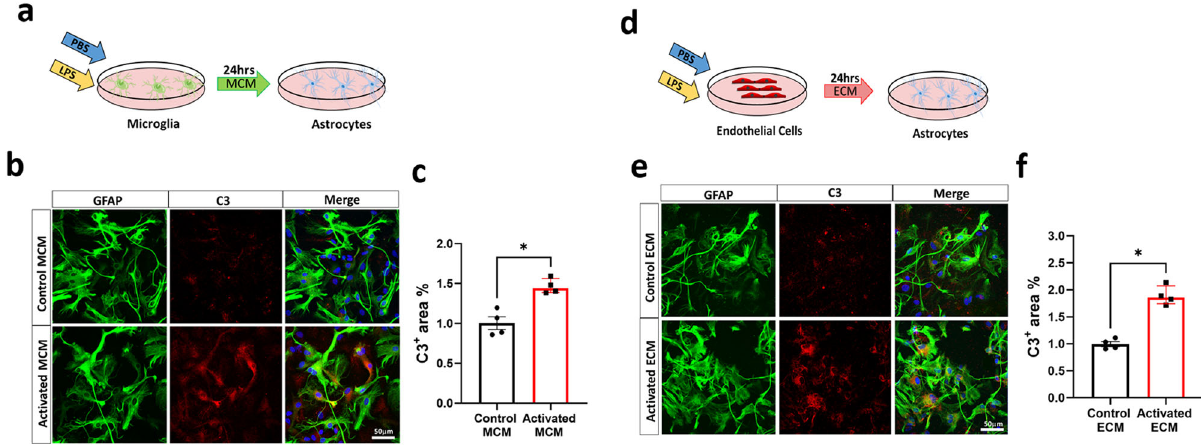
Fig. 1 C3 + Astrocytes are induced by LPS-Activated ECM. a Schematic diagram showing treatment of astrocytes with control or activated microglia conditioned medium (MCM) b Double immuno fl uorescence of complement component 3 (C3, red) and astrocytes (GFAP, green) treated with control or activated MCM in primary astrocyte cultures. C3 and GFAP immunoreactivity overlay (merge) c Quanti fi cation of C3 + area (%) of control or activated MCM treated astrocytes. d Schematic diagram showing treatment of astrocytes with control or activated endothelial conditioned medium (ECM) e Double immuno fl uorescence of complement component 3 (C3, red) and astrocytes (GFAP, green) treated with control or activated ECM in primary astrocyte cultures. C3 and GFAP immunoreactivity overlay (merge) f Quanti fi cation of C3 + area (%) of control or activated ECM treated astrocytes. The number of cells analyzed was 20 per image from 10 different images per culture from 4 independent cultures. Results are shown as the median ± IQR of n = 4. Asterisks indicate signi fi cant differences, where * p < 0.05 by Mann-Whitney test. Scale bar 50 μ